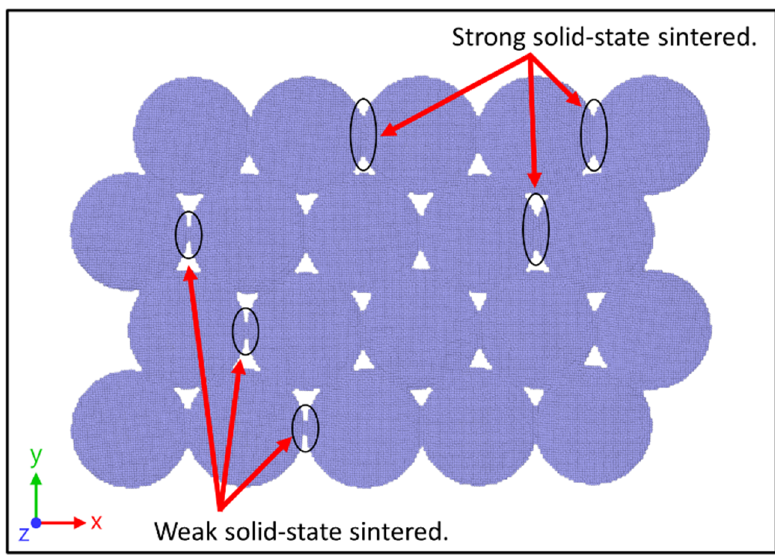
Figure 5. The C-type stacked-NPs model with a core volume fraction of 12% after solid-state sintering contains some connection positions that are weakly solid-state sintered.